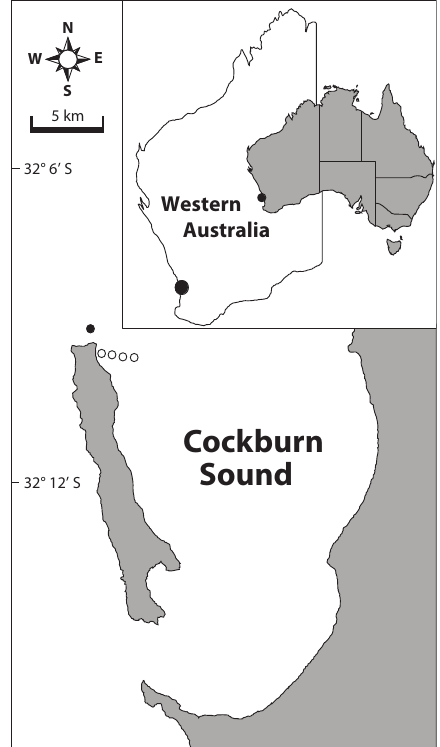
Figure 1. Location of the study sites, Cockburn Sound, Western Australia (Australia). White dot points represent the coring sites in seagrass P. sinuosa meadows at 2, 4, 6 and 8m depth (from west to east). Bare sediment core is indicated by a black dot